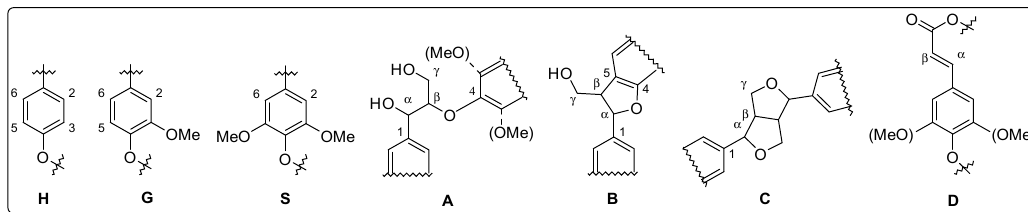
Figure 12. Lignin structure elements for heteronuclear single quantum correlation (HSQC) NMR signal assignment (A: β -O-4’ linkage, B: phenylcoumaran, C: resinol, D: β -unsaturated ester). Reprinted from [27] under open access license.